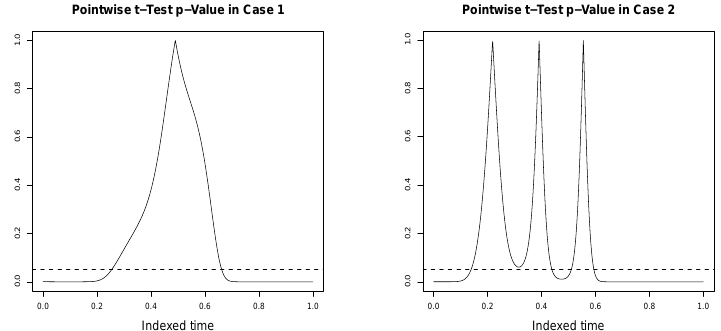
Figure 6. P -values obtained for the values of t in interval [0, 1] in the solid line and the reference line of 0.05 of significance in the dashed line for case 1 ( left ) and case 2 ( right